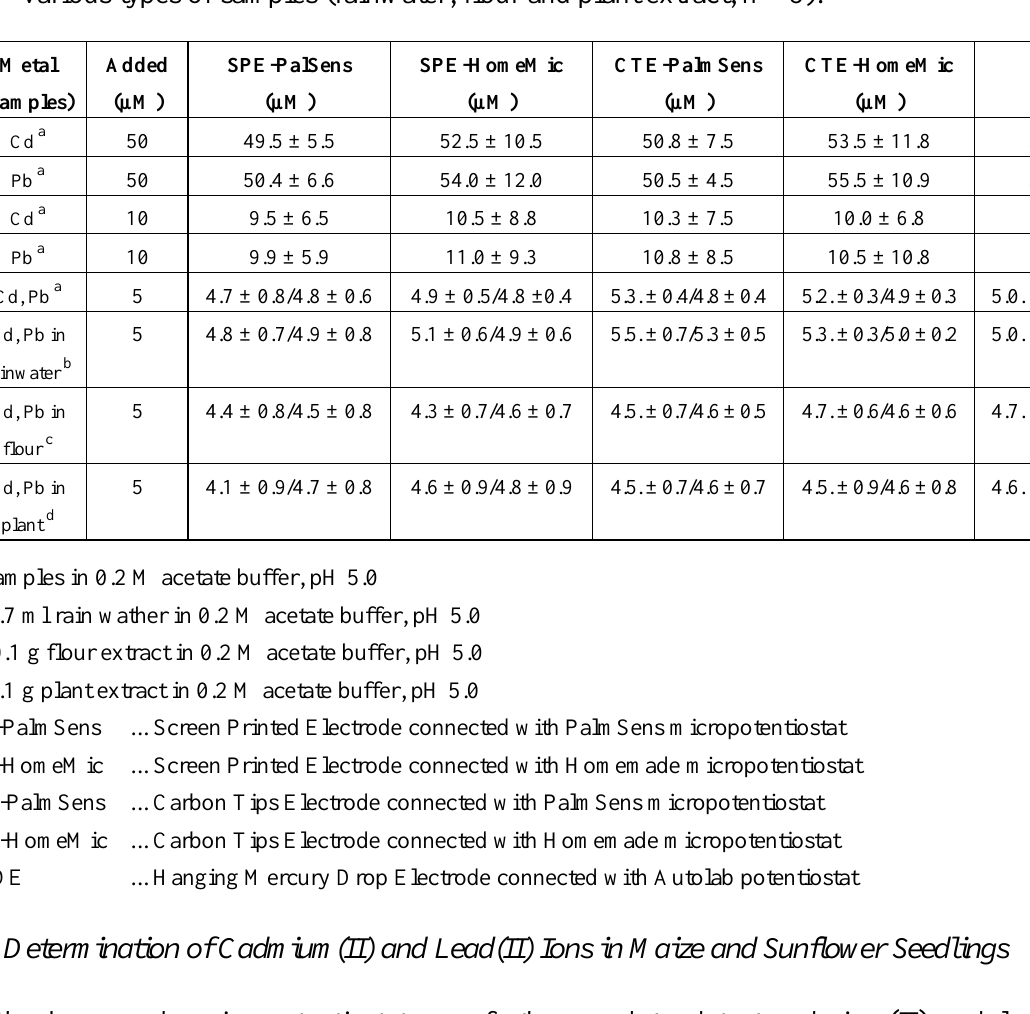
Table 2. Comparison of detection of cadmium(II) and lead(II) ions artificially added to various types of samples (rainwater, flour and plant extract, n =